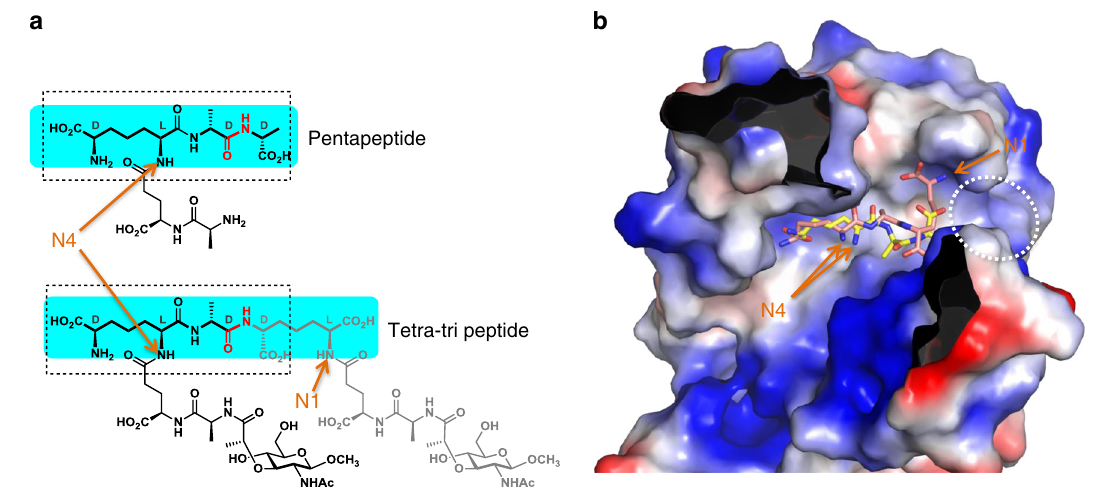
Fig. 4 Structural comparison of binding modes of penta- and tetra-tri peptides to Pgp3. a Alignment of the shared structural attributes for the pentapeptide and tetra-tri peptide, identi fi ed in the bound ligands. The scissile bonds are depicted in red. The shared structural component between the two substrates is in dotted box with the segments whose electron densities were observed highlighted in the shade boxes in cyan. b Surface representation of the electrostatic potential of Pgp3 in complex with pentapeptide (yellow) and tetra-tri peptide (pink). The positions of N1 and N4 atoms of each peptide are indicated by arrows. Solvent-exposed region next to the N1 atom of tetra-tri peptide is indicated by white dotted lines.